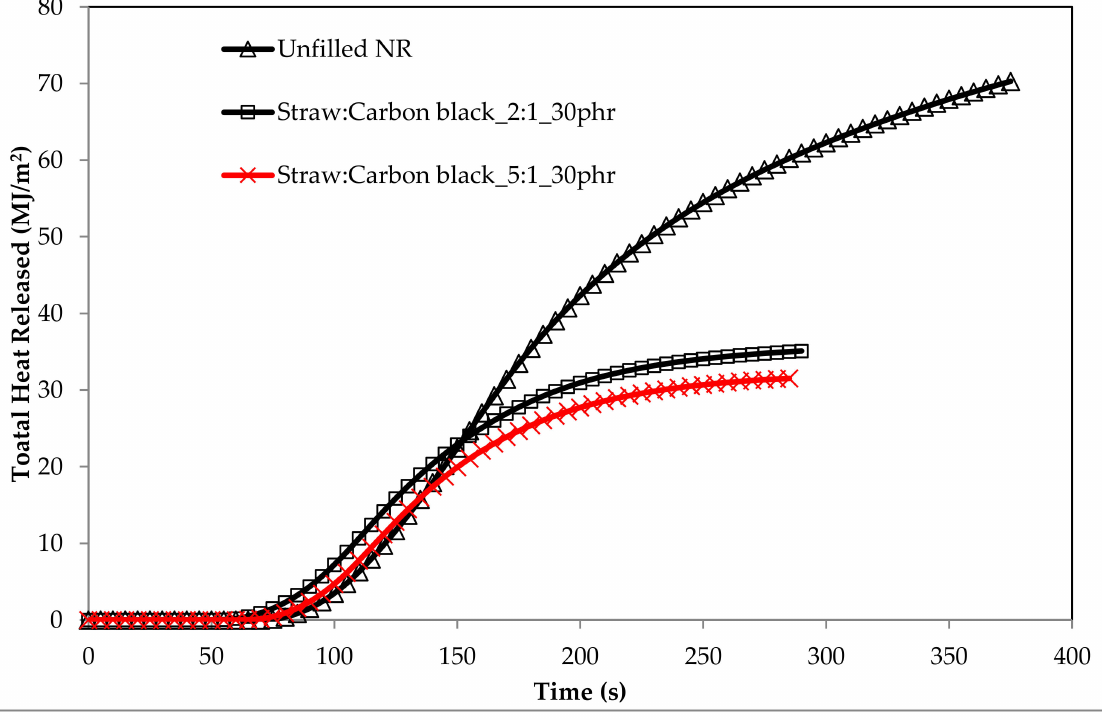
Figure 21. The THR curves of vulcanizates filled with 30 phr of straw:carbon black